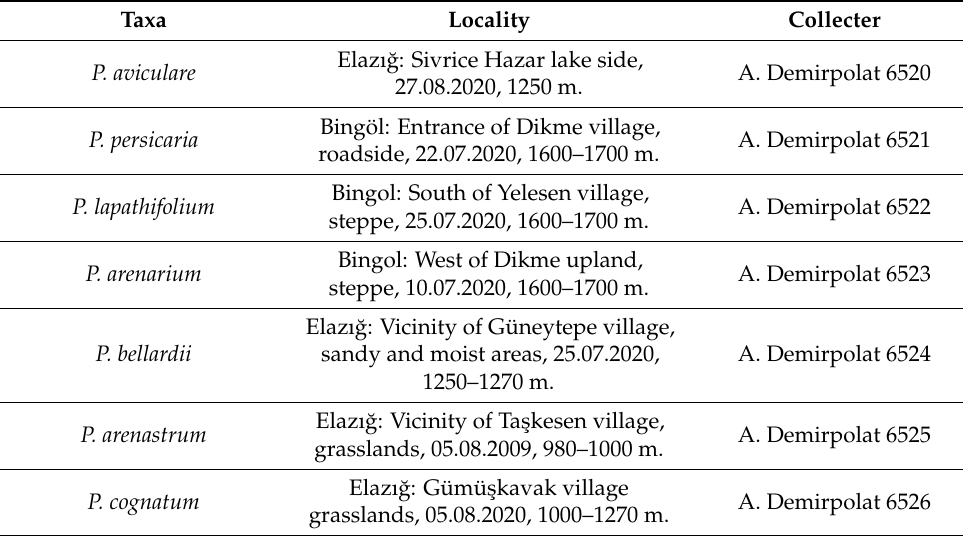
Table 2. The locality information of collected Polygonum